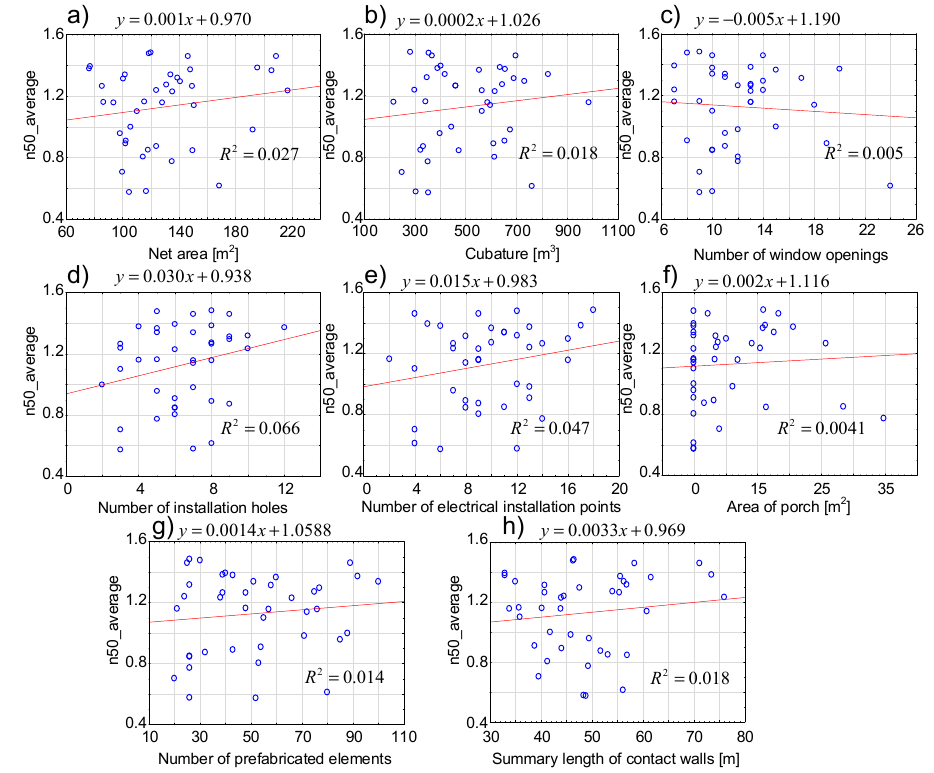
Figure 8. Scatter plots of the results ( a ) n 50 —net area ( b ) n 50 —cubature ( c ) n 50 —number of win- dow openings ( d ) n 50 —number of installation holes ( e ) n 50 —number of electrical installation points ( f ) n 50 —area of porch ( g ) n 50 —number of prefabricated elements ( h ) n 50 —summary length of con- tact walls.